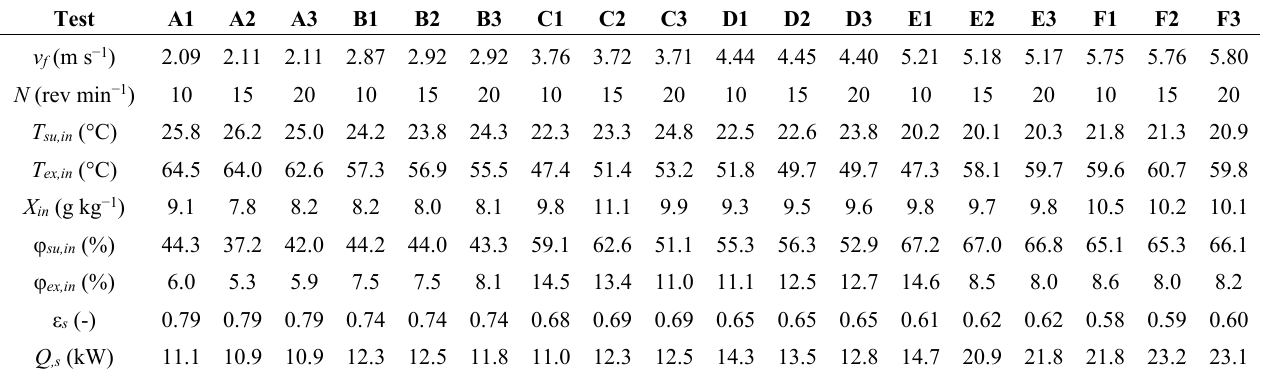
Table 2. Experimental sensible effectiveness: Test conditions and measured